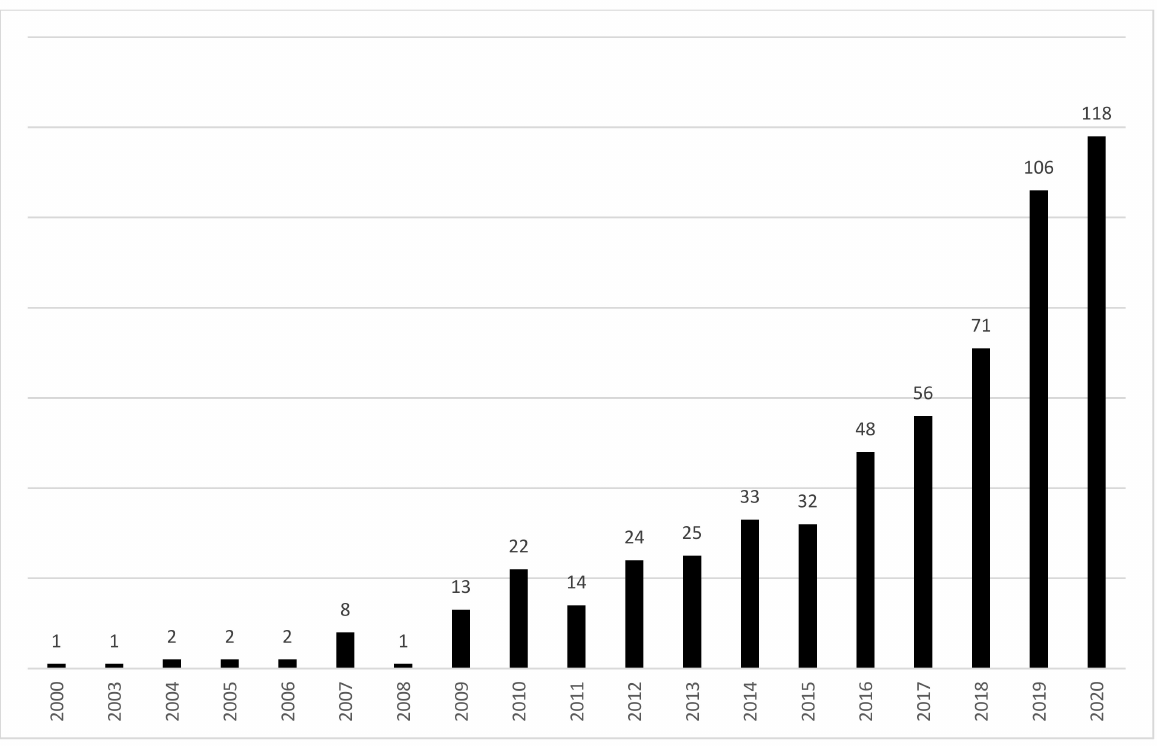
Figure 4. Publications per year between 2000 and